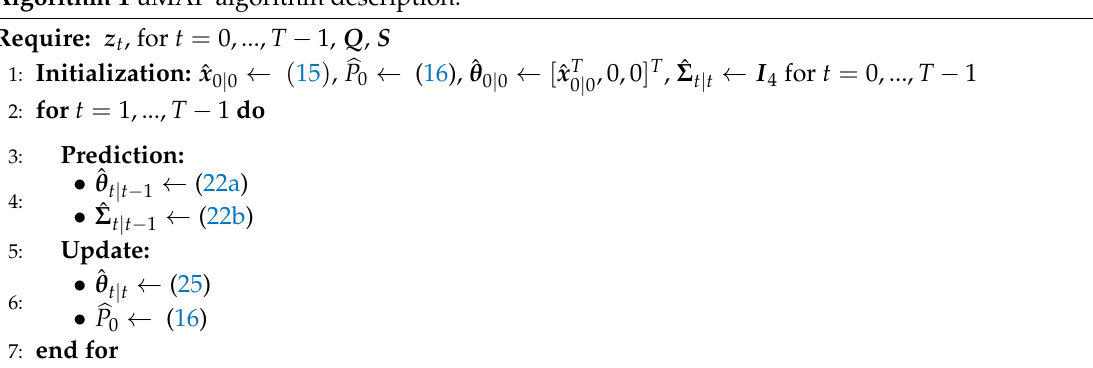
Algorithm 1 uMAP algorithm description.